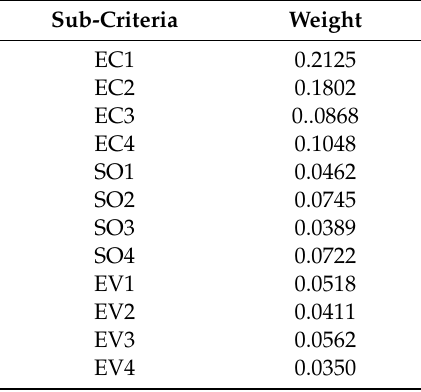
Table 6. The weights of all sub-criteria.